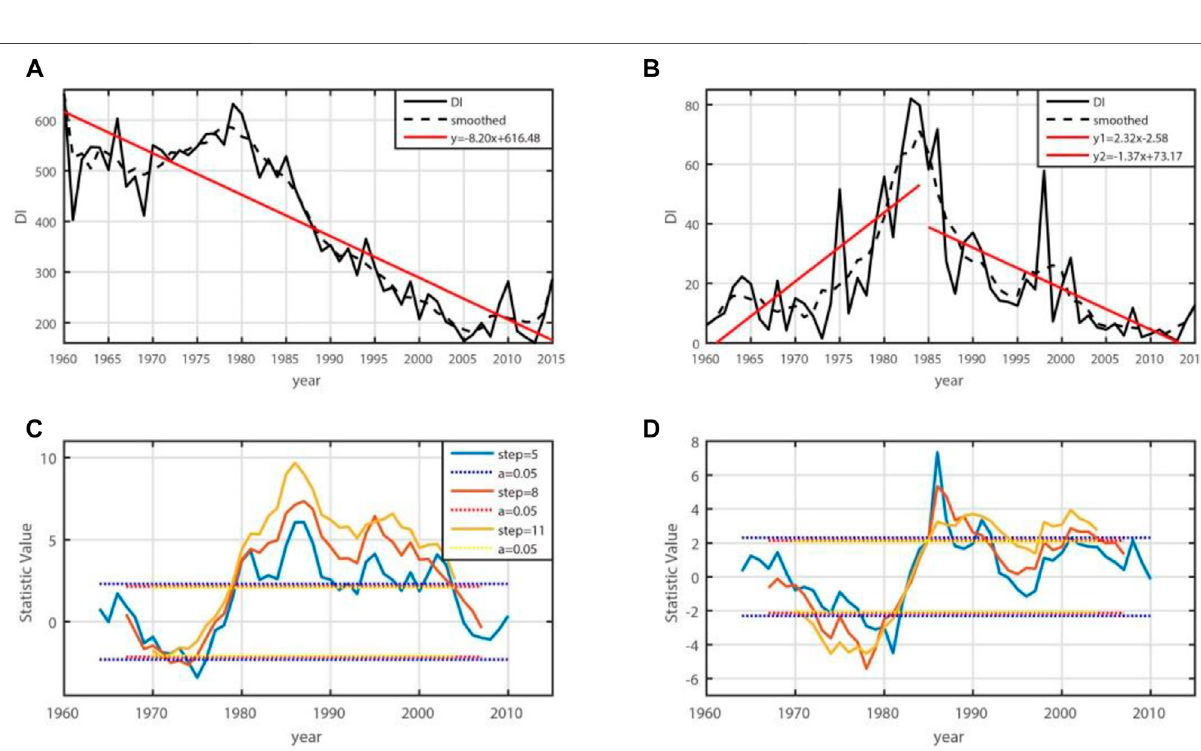
Frontiers in Environmental Science |